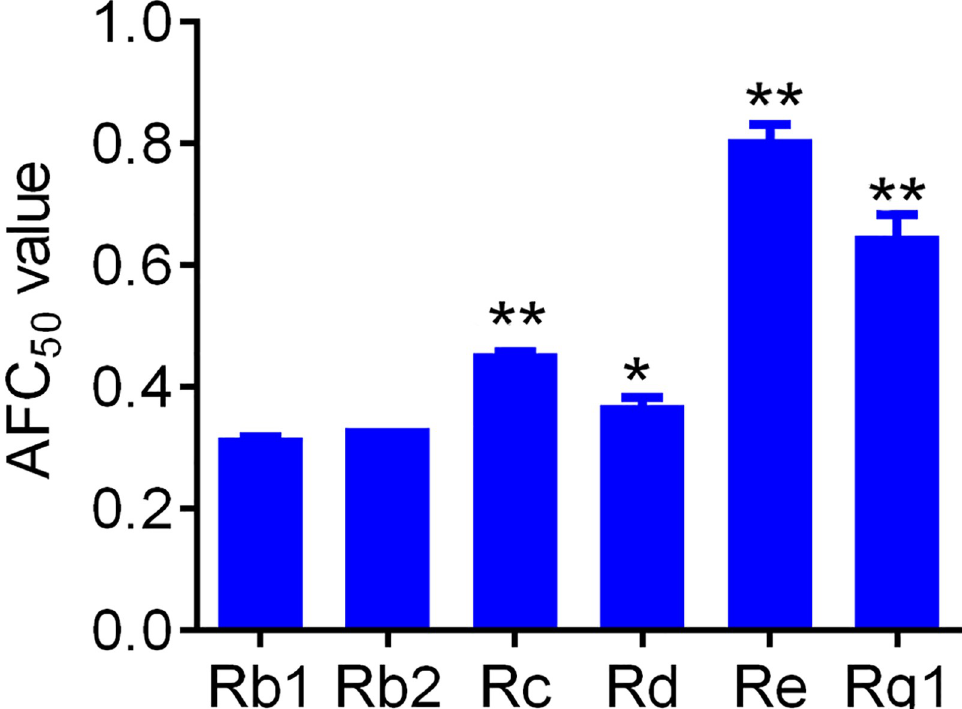
Fig 6. The Median antifeedant concentration (AFC 50 ) of ginsenosides at 48 h. � and �� notes p < 0.05 and 0.01 vs. Rb1, respectively.